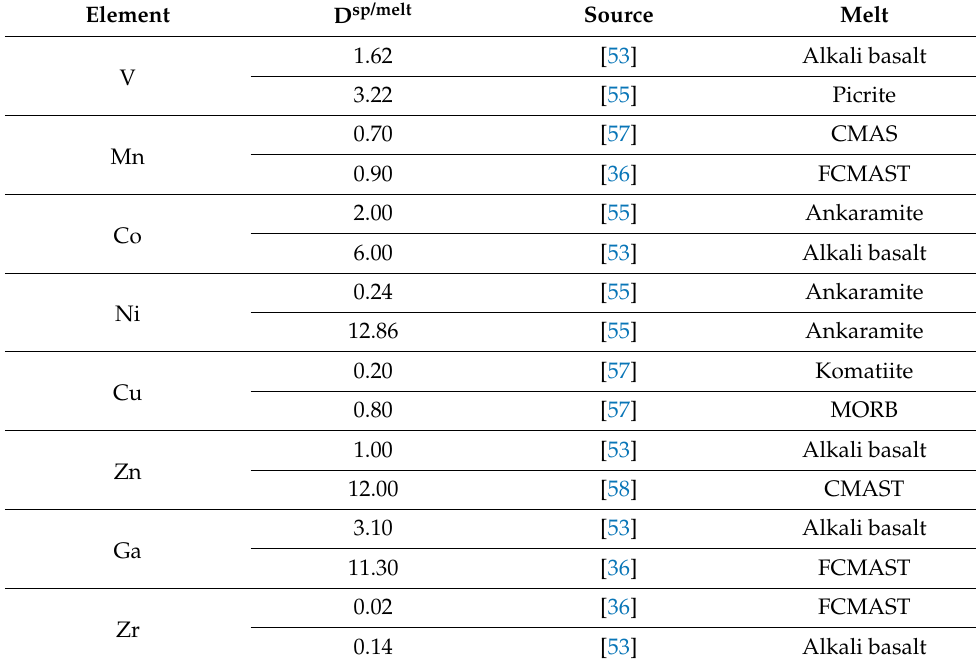
Table 1. List of partition coefficients selected, relative source and composition of melts considered in the